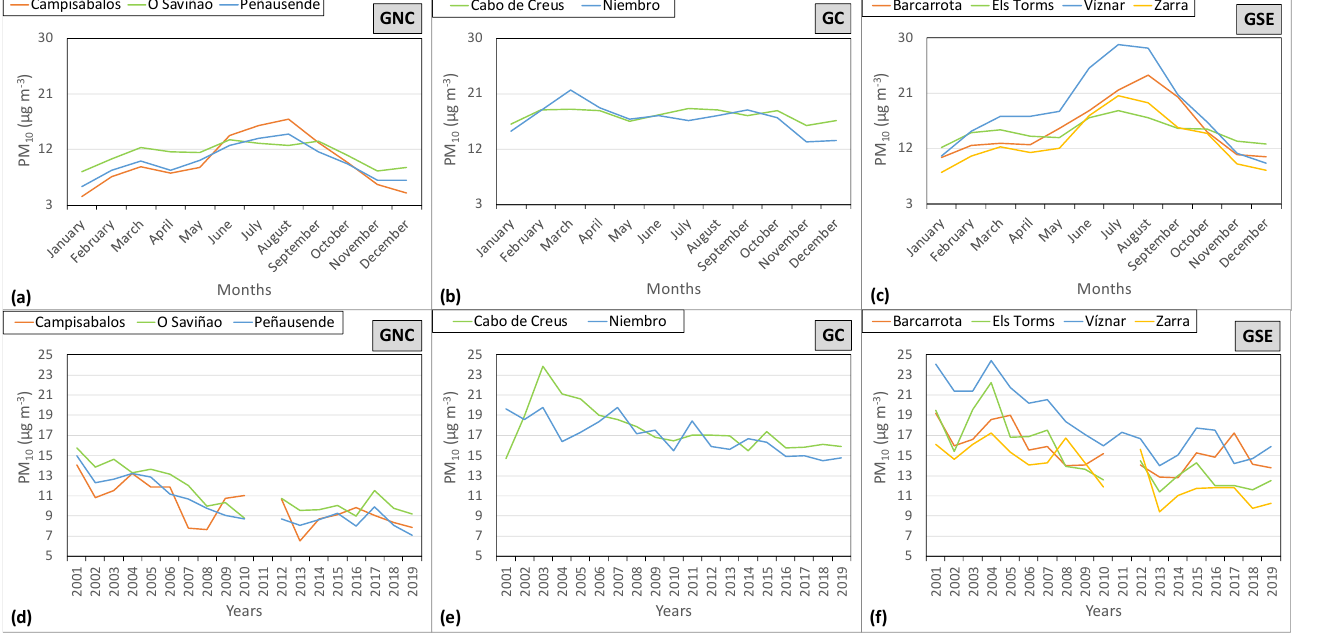
Figure 3. Monthly ( a – c ) and yearly ( d – f ) evolution of PM 10 for the clustering group and station for the study period 2001 – 2019.